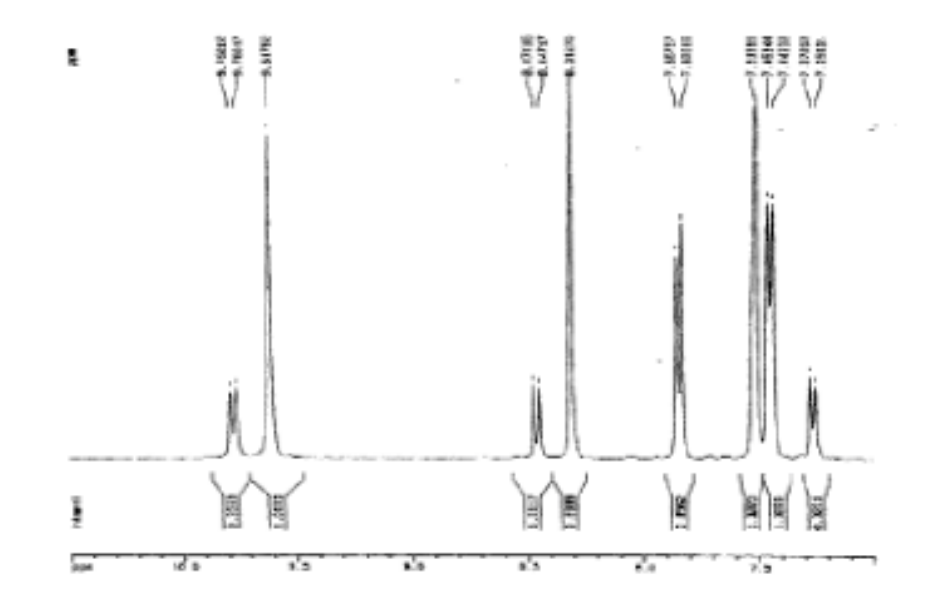
Figure 2. Aromatic part of the 1 H-NMR spectrum of 5 (in DMSO- d